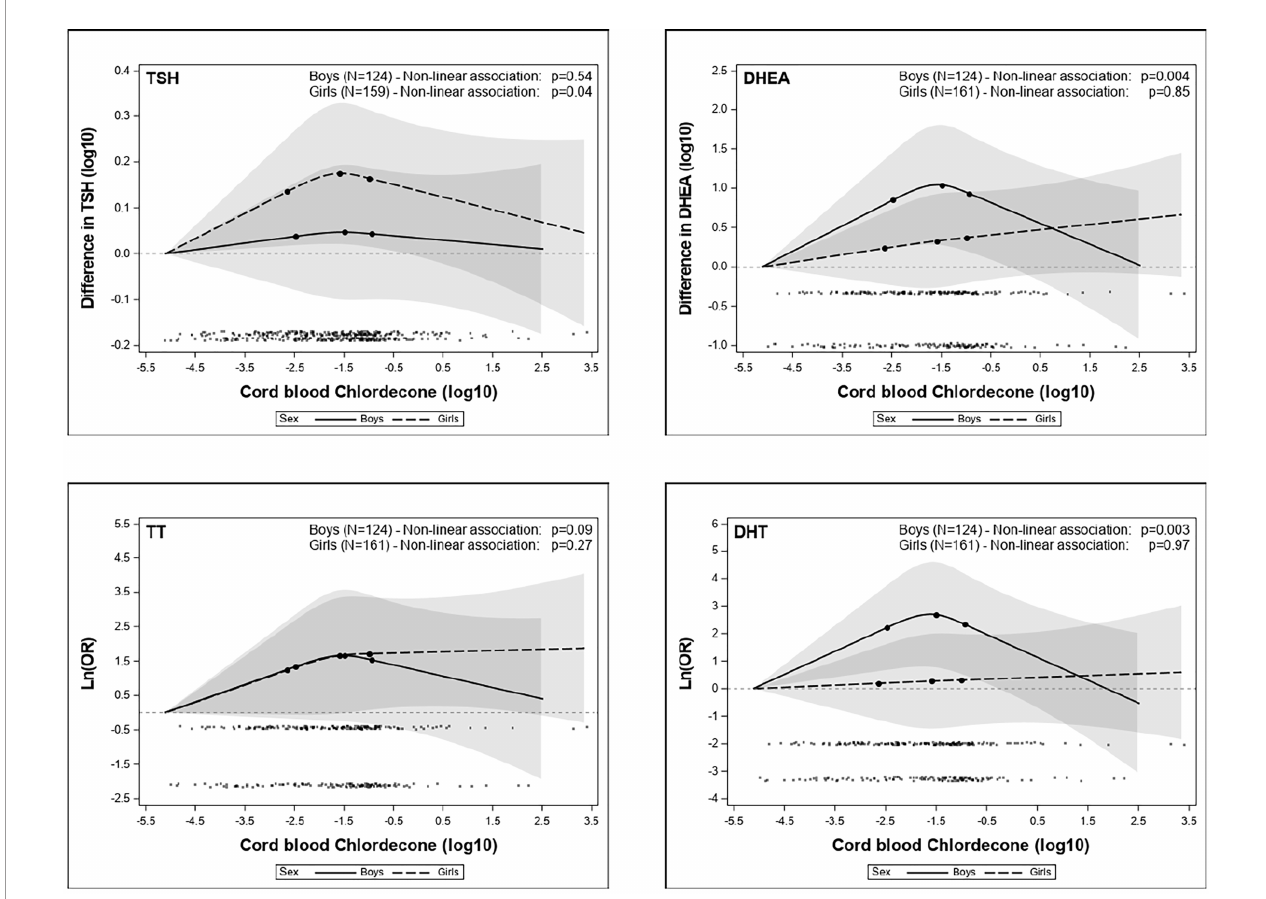
FIGURE 1 | Exposure-response associations (adjusted generalized additive models, restricted cubic splines). Horizontal axis: log 10 (cord blood chlordecone concentration, µg/L). Vertical axis: difference in log 10 TSH (mIU/L), log 10 DHEA (nmol/L), Ln (OR) TT (above vs below the detection limit), and Ln (OR) DHT (above vs below the detection limit) estimated for various levels of exposure compared to the minimal exposure observed. Black points at the bottom of the graph represent the observed values of chlordecone